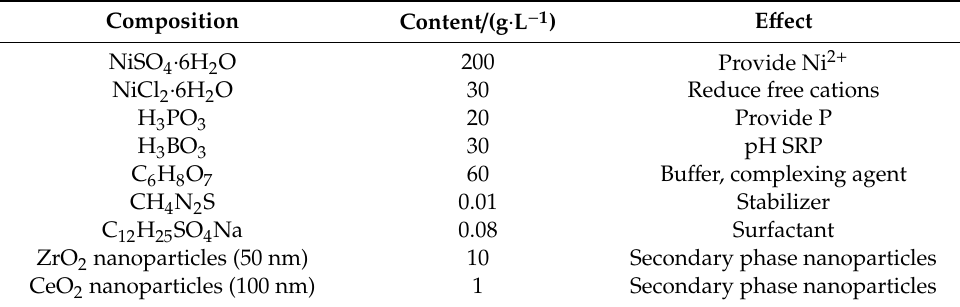
Table 1. Composition of plating